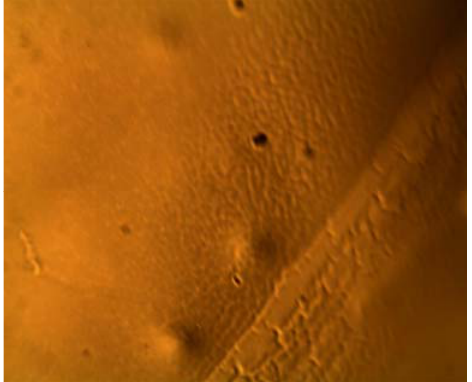
Figure 4. Image of the surface SiCN thin films at X 100: No visible crack appears on the surface.